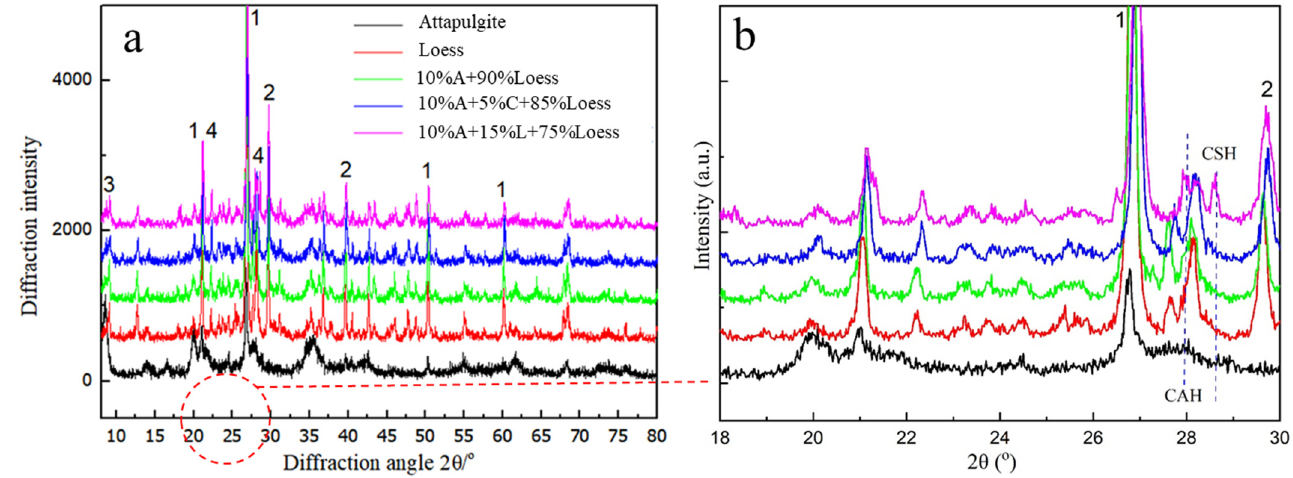
Figure 8. XRD test results of modified loess. ( a ) The XRD test results of loess and modified loess, ( b ) Enlarged view of XRD test results between 18° and 30°. (1, quartz; 2, calcite; 3, clay minerals; 4, feldspar, 5, palygorskite. A, attapulgite, L, lime, C, cement).